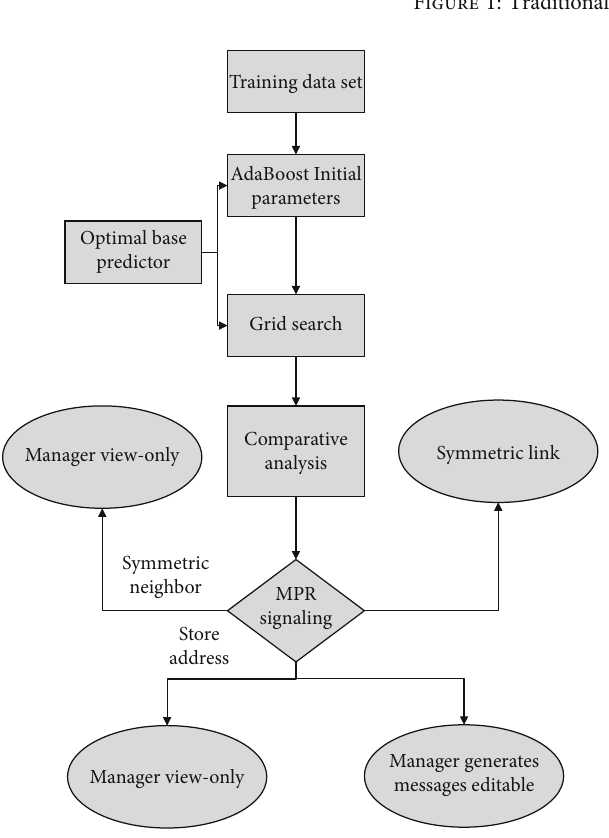
Figure 2: AdaBoost algorithm fl